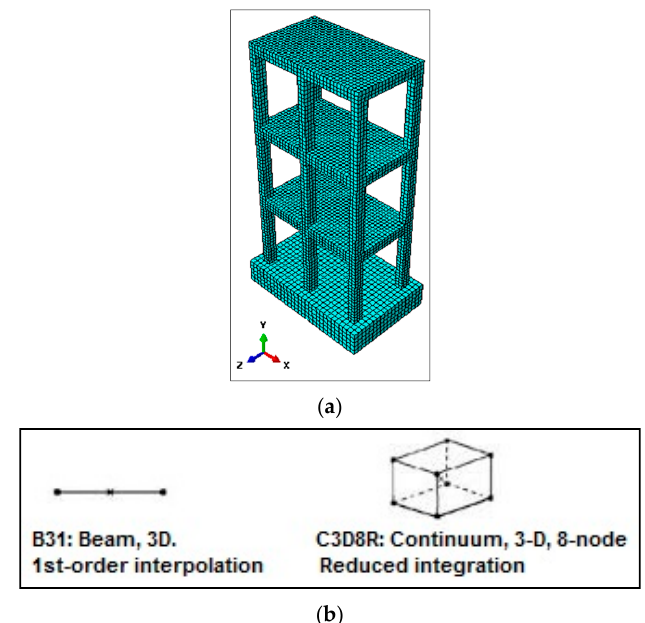
Figure 3. ( a ) FE model of building. ( b ) Solid finite element model Shows the element adopted by